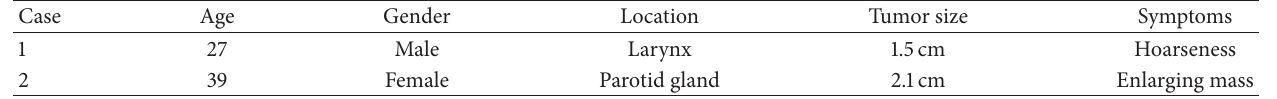
Table 1: Clinical characteristics of the alveolar soft part sarcoma